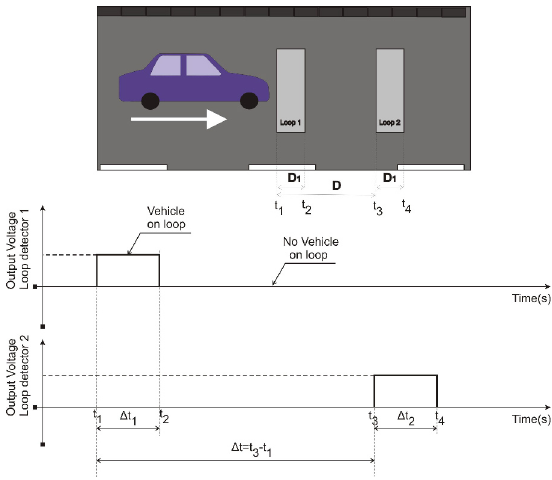
Figure 6. The principle of detecting the instantaneous velocity and vehicle